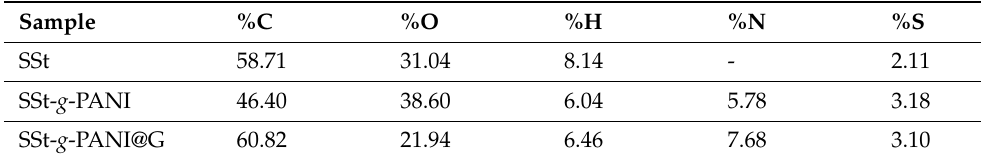
Table 1. The result of elemental analysis (CHNSO) of sulfonated starch (SSt), sulfonated starch- graft -polyaniline (SSt- g -PANI), and the sulfonated starch- graft -polyaniline@graphene (SSt- g